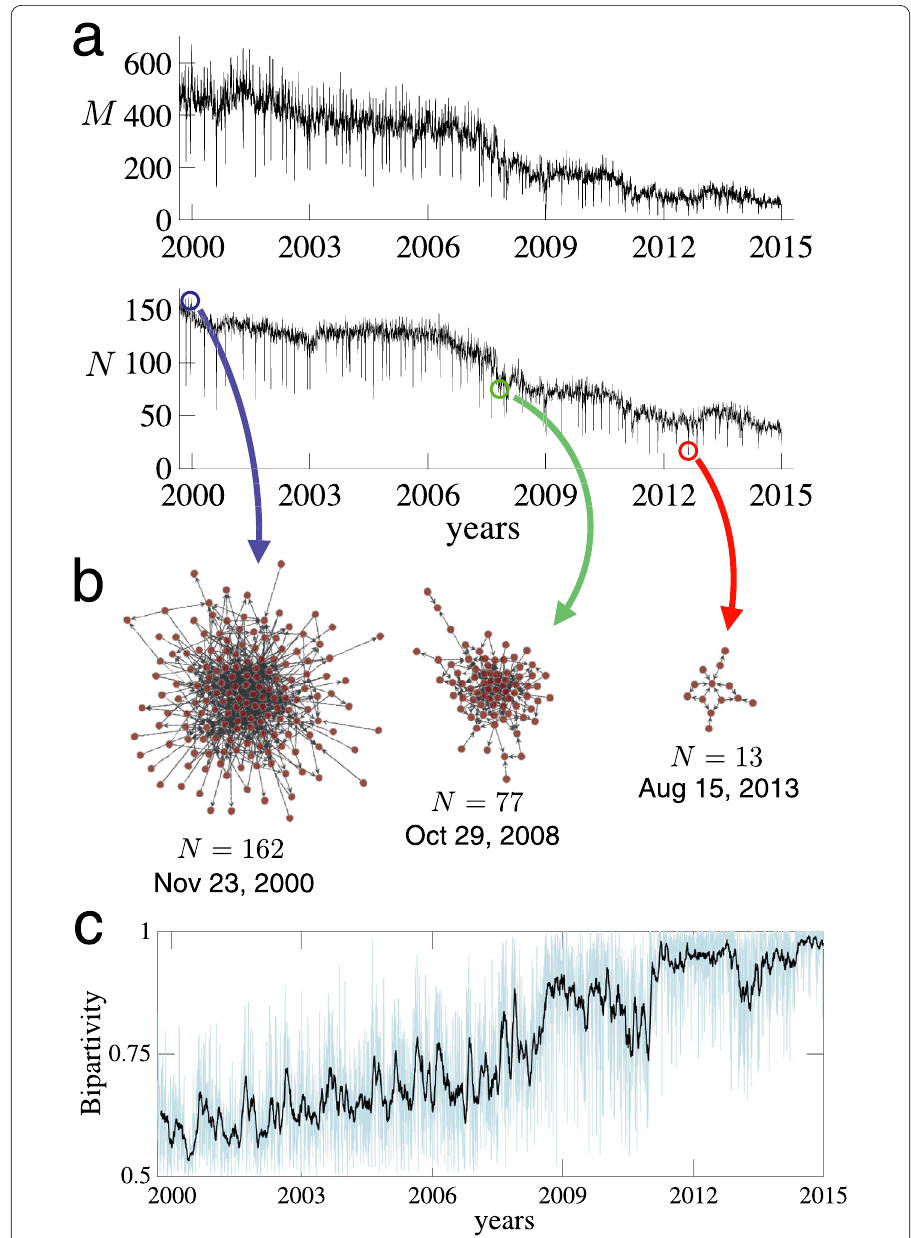
Figure 1 Time series of daily networks. ( a ) Daily time series of the number of edges M (upper) and the number of banks N (lower). Most of the downward spikes in N and M are due to the national holidays in Italy. ( b ) Visualization of the largest (left), a middle-sized (middle) and the smallest (right) daily networks (visualized by graph-tool [65]) ( c ) Time series of bipartivity. Bipartivity is a measure of bipartite structure defined as (cid:2) (cid:2) ˆ λ ˆ λ {ˆ λ N N } denotes the eigenvalues of the adjacency matrix. The bipartivity i )/ i ), where i i =1 cosh( i =1 exp( measure takes 1 if the network is fully bipartite and 0.5 if a complete graph [66]. Since the bipartivity is defined for undirected graphs, we ignore the directionality of edges. Black line represents the moving average with 20-day smoothing window